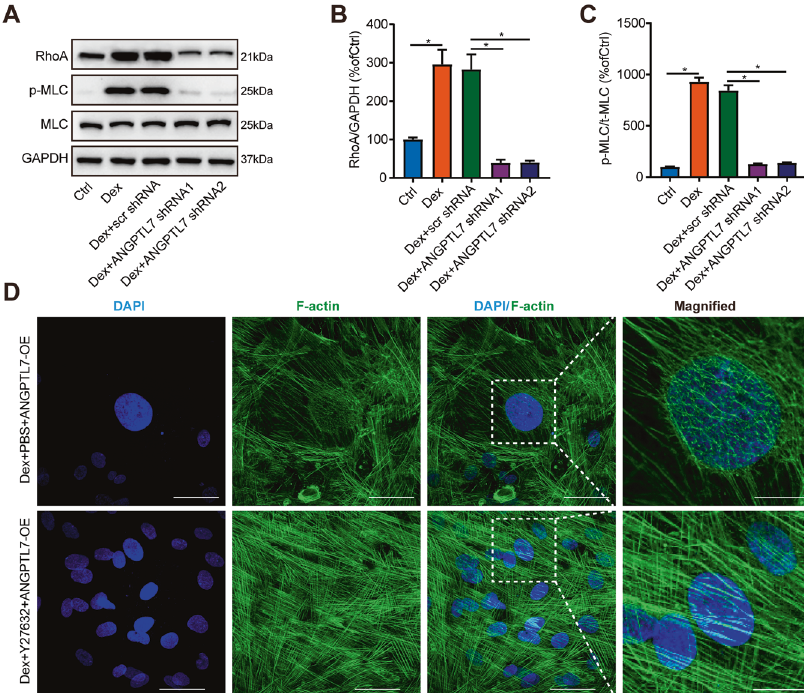
Fig. 4 Effects of ANGPTL7 on the RhoA/ROCK pathway. A – C The expression of critical proteins (RhoA, phosphorylated MLC, and MLC) of the RhoA/ROCK pathway were detected using western blotting in TM cells treated with and without DEX and transfected with scr shRNA and ANGPTL7 shRNAs (shRNA1, shRNA2). The protein levels of RhoA and p-MLC were distinctly increased in TM cells with DEX treatment and dramatically decreased in the DEX + ANGPTL7 shRNAs (shRNA1, shRNA2) group compared with the DEX + scr shRNA group. D Representative images of actin fi laments of TM cells transfected with ANGPTL7-OE (60× magni fi cation). The insets show regions at higher magni fi cation (200×). ROCK inhibitor Y27632 was used to inhibit the RhoA/ROCK pathway, while PBS was used as a control. Even though ANGPTL7 was overexpressed, the formation of CLANs was suppressed in the DEX + Y27632 + ANGPTL7-OE group compared with the DEX + PBS + ANGPTL7-OE group. Blue: DAPI; green: F-actin. N = 3 from three biological replicates. * P <